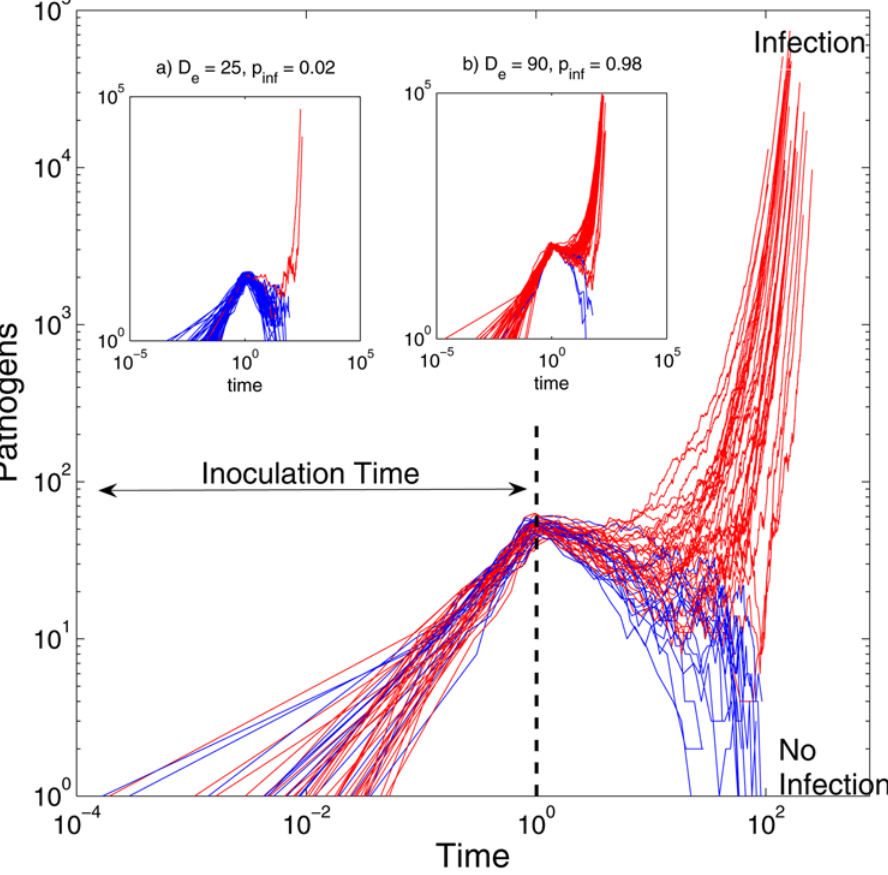
Figure 1. Evolution of the number of pathogens over time for a characteristic parameter set h P , d P , a I , ª I , d I , l I f gf g ~ f 0 : 15 , 0 : 01 , 0 : 4 , 0 : 01 , 0 : 005 , 0 : 05 f gg . Each line represents an individual replicate with the same parameter set (100 in total). The fraction of replicates in which the number of pathogens diverge towards infinity, as opposed to going extinct, is equivalent to the probability of infection ( p inf ) for the dose D e ~ 60 (main graph, D e ~ 25 and D e ~ 90 for the insets a) and b) respectively). Temporal exposure length is fixed at T e =1 hour. Probability of infection is 0.67, 0.02 and 0.98 for the main graph, the inset a), and the inset b)